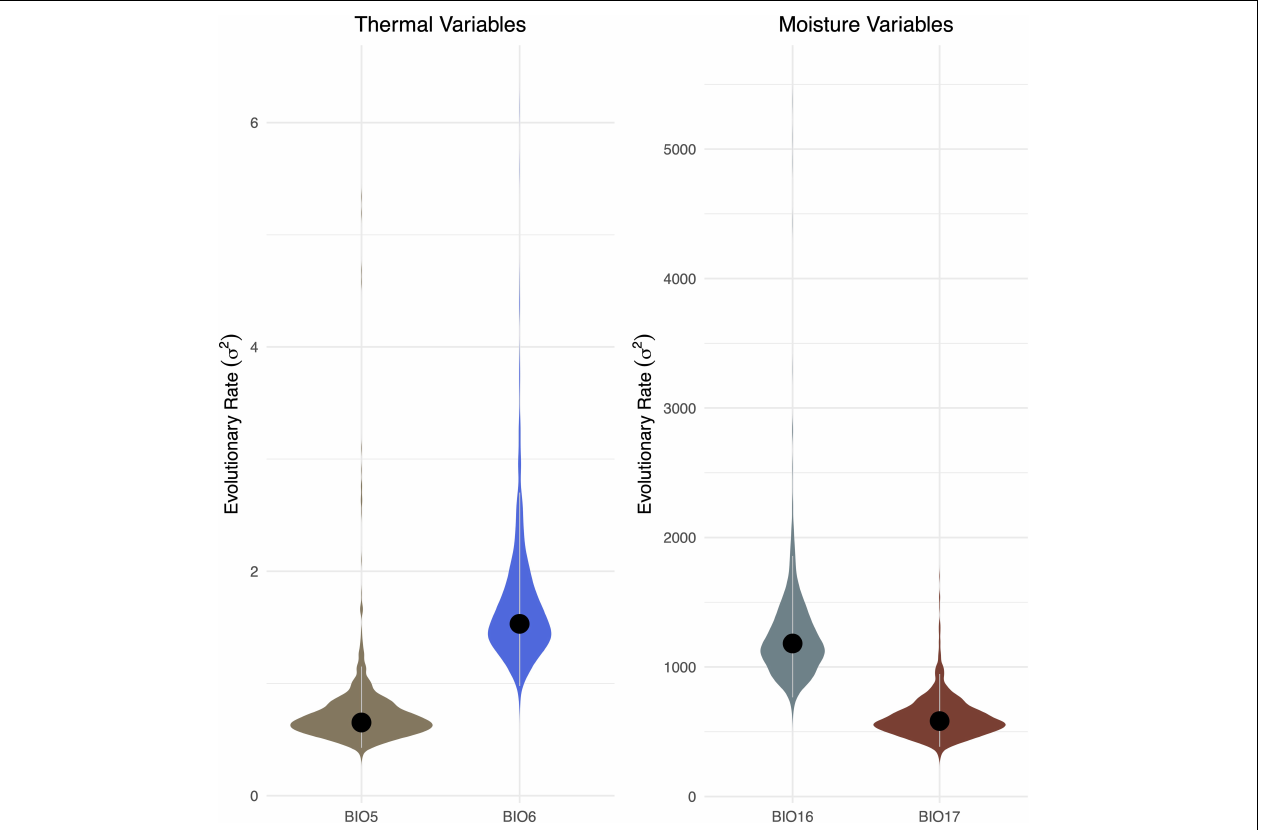
FIGURE 4 | Comparison of rates of evolution among four (BIO5 vs. BIO6; BIO16 vs. BIO17) bioclimatic variables. Values derived from analyses using the MCC tree are indicated with a black dot. Violin plots represent the distribution of values conducted on the 1,000 trees derived from the posterior. The 95% HPD of value is indicated with gray